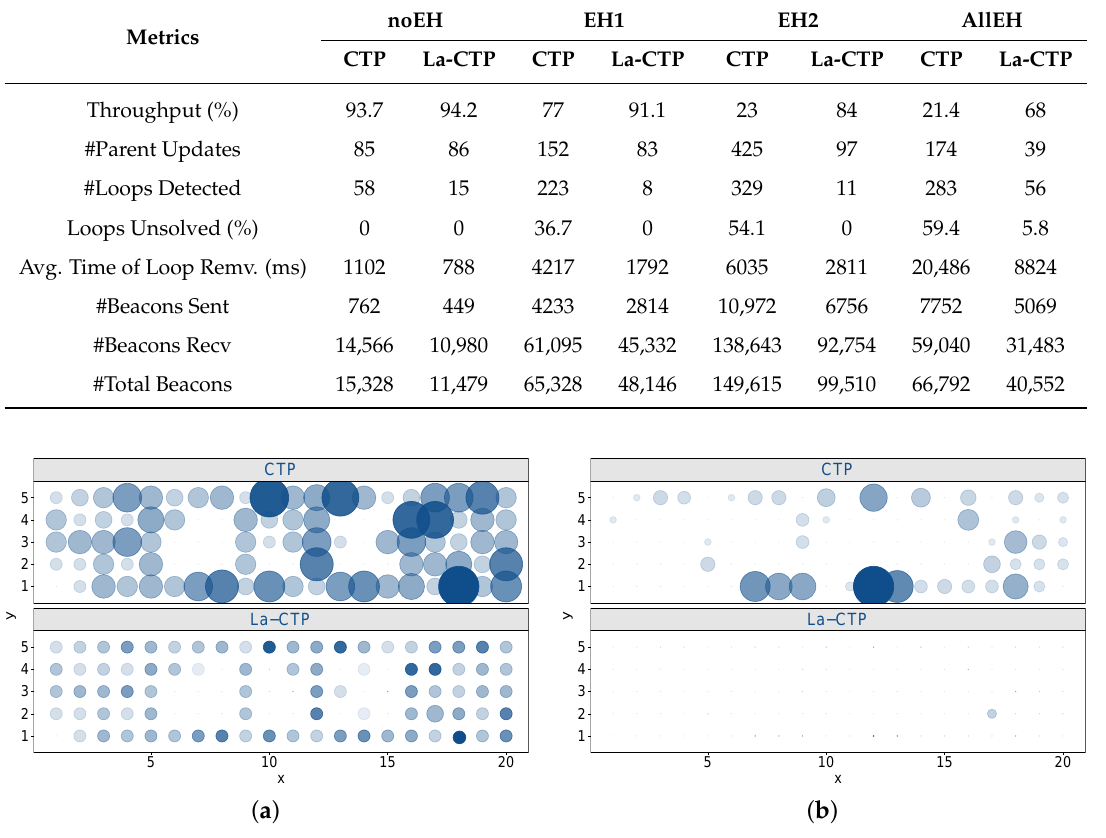
Figure 9. Comparisons in parent updates and loop detections under two protocols running in EH2. ( a ) parent updates; ( b ) loop